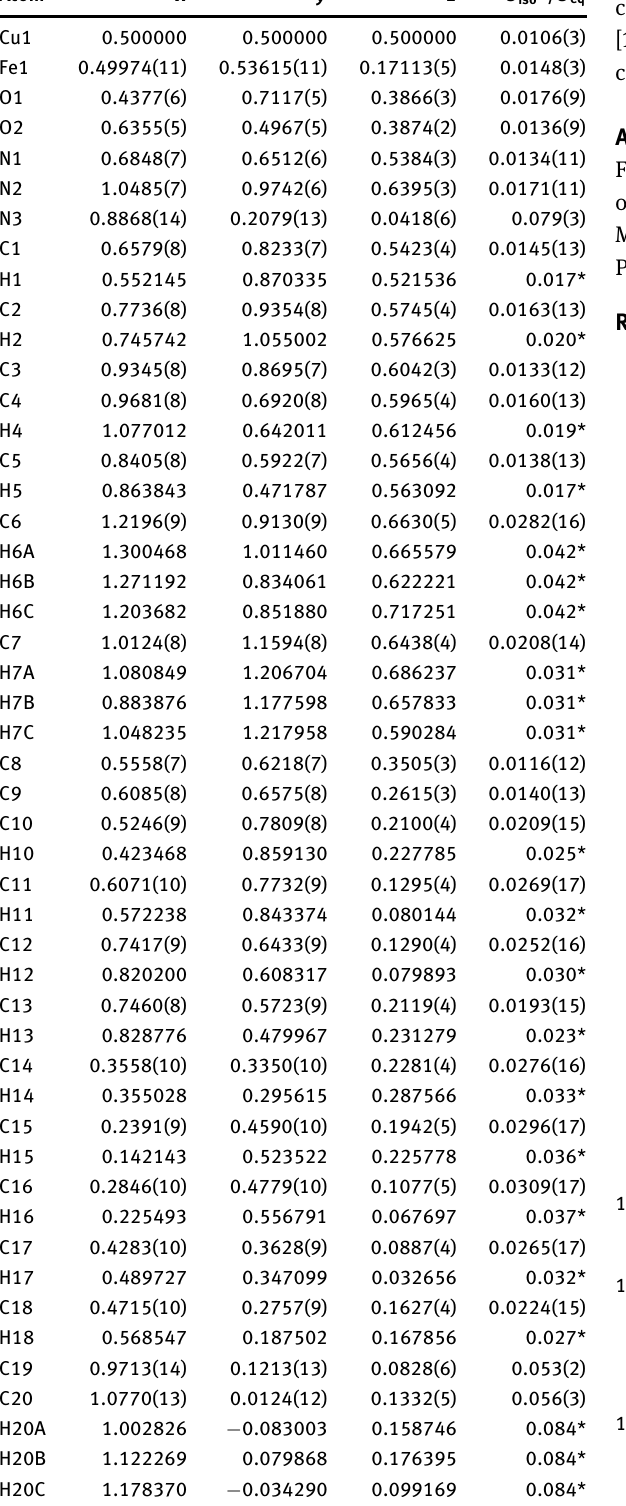
Table 2: Fractional atomic coordinates and isotropic or equivalent isotropic displacement parameters (Å 2